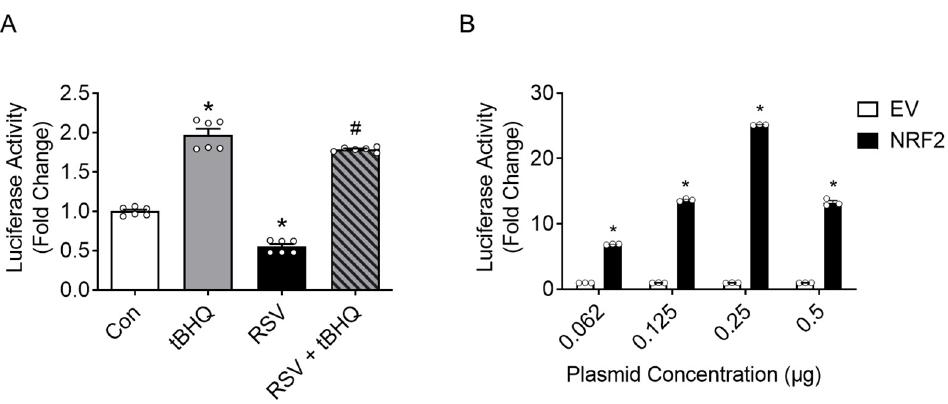
Figure 2. CSE promoter activity in response to RSV infection, tBHQ stimulation and NRF2 expression. iSAE cells were transfected with -973 CSE-PGL4-Luc and Renilla-Luc plasmid (pRL-CMV) in 24-well plates. After 24 h, transfected cells were left untreated (control) or treated with tBHQ (25 µM) for 15 h or infected with RSV for 24 h alone or in combination with tBHQ (RSV + tBHQ). Luciferase activity was normalized to Renilla luciferase activity. Results are expressed as mean ± SEM of triplicate determination of a representative experiment repeated twice and expressed as fold change relative to control. * p < 0.05 relative to control cells, # p < 0.05 compared to RSV infected cells ( A ). iSAE cells were co-transfected with increasing amounts of NRF2 expression vector or the corresponding empty vector and harvested 48 h post transfection to measure luciferase activity. Luciferase activity was normalized to Renilla luciferase activity. Results are expressed as mean ± SEM of triplicate determination of a representative experiment repeated twice and expressed as fold change relative to control. * p < 0.05 relative to empty vector ( B ). Each circle represents individual data.